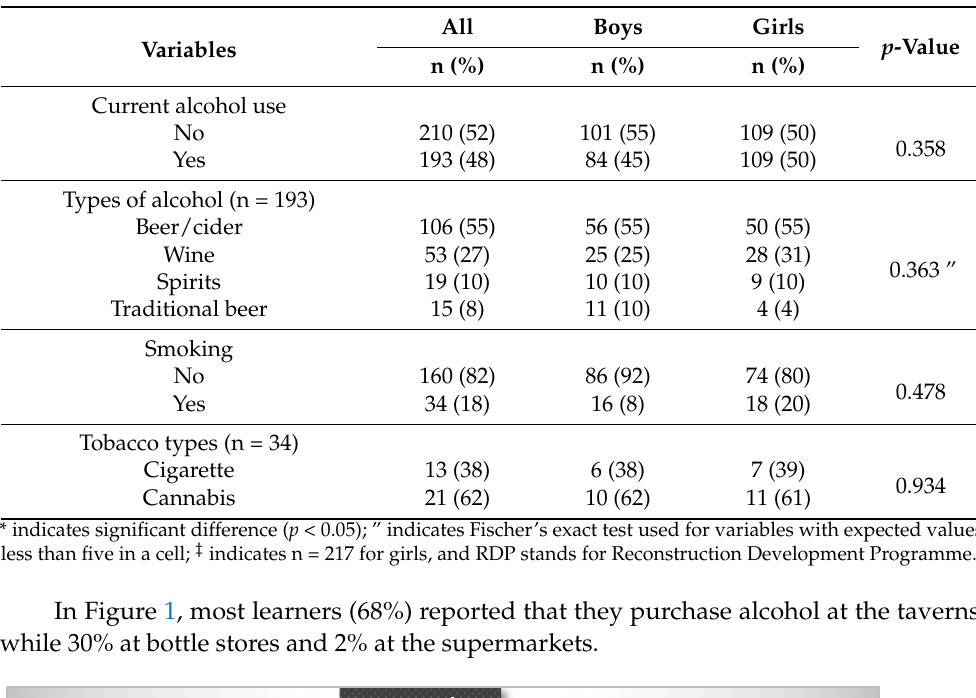
Table 2. Accessibility and motivations of alcohol use among school learners.